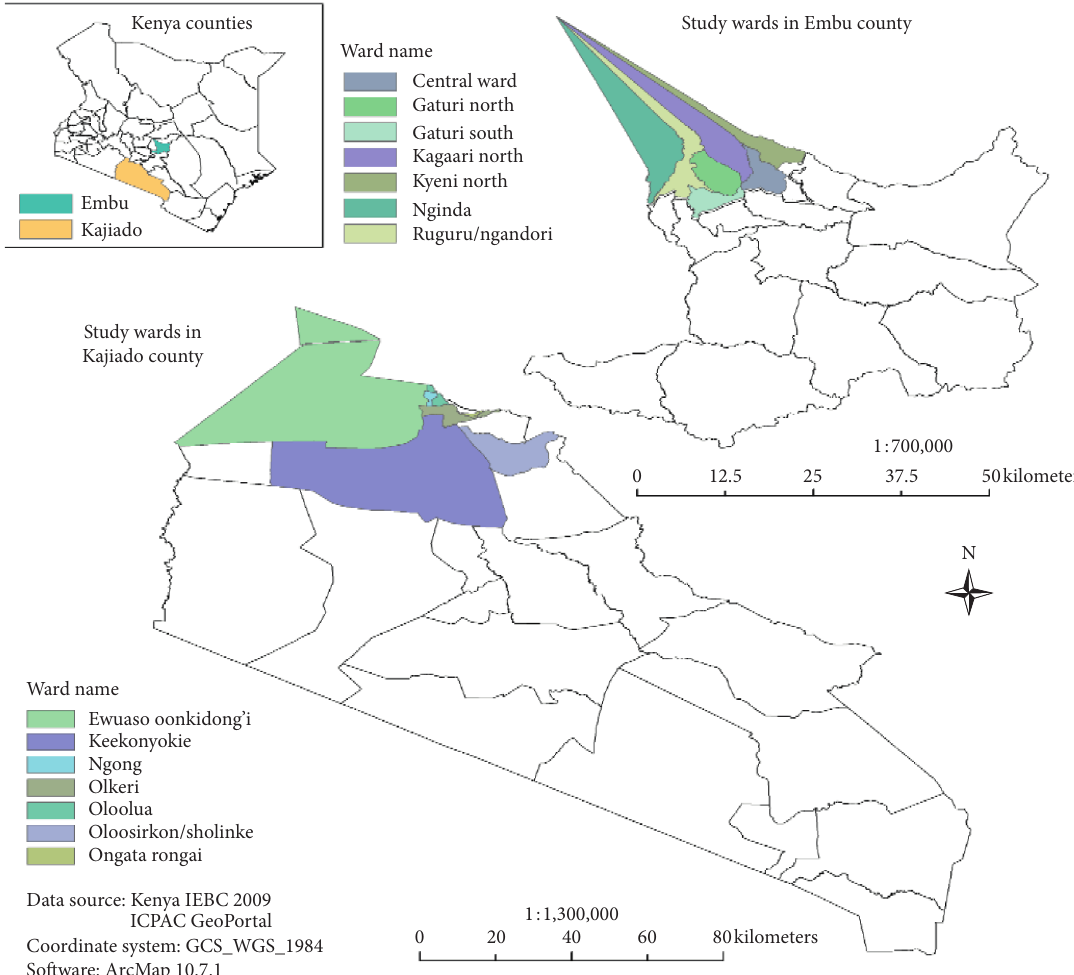
Figure 1: Map of the Embu and Kajiado showing the study